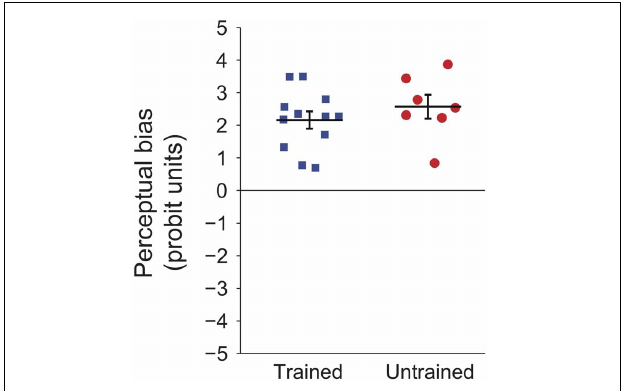
FIGURE 2 | Individual probit transformed bias summed across retinal locations for participants in the first experiment. Black lines indicate group means and error bars show standard error.